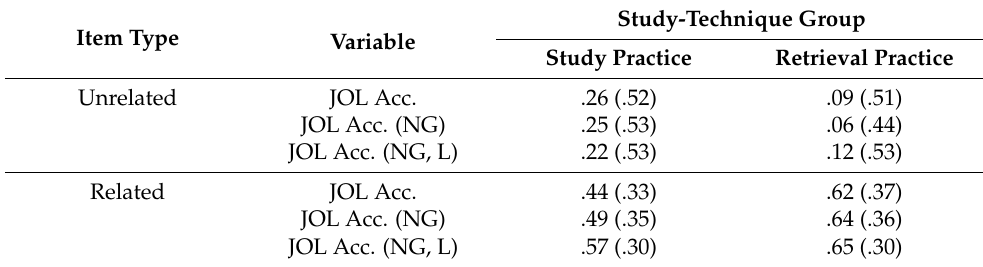
Table 7. JOL accuracy across levels of correct-guessing adjustment.